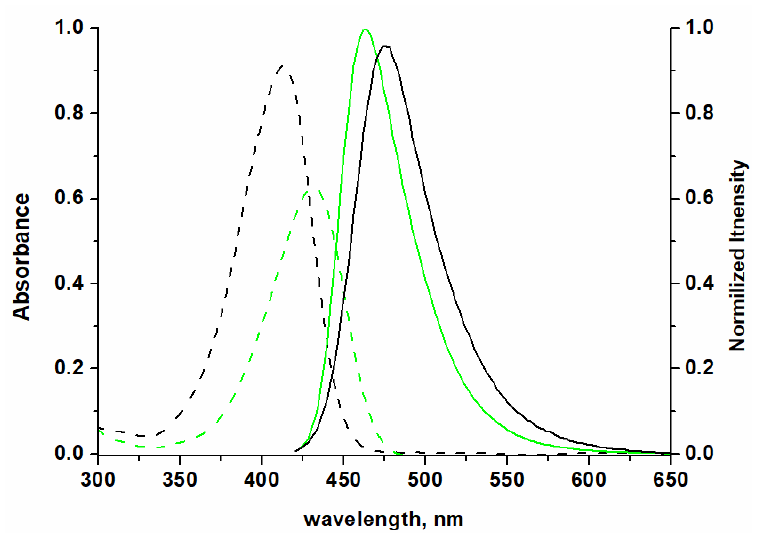
Figure 4. UV–vis (dashed line) and normalized emission (solid line) spectra of coumarin 2a in CH 3 CN (c = 1.5 × 10 − 4 M, blue) and conjugate 4a in water (c = 0.5 × 10 − 4 M, red).